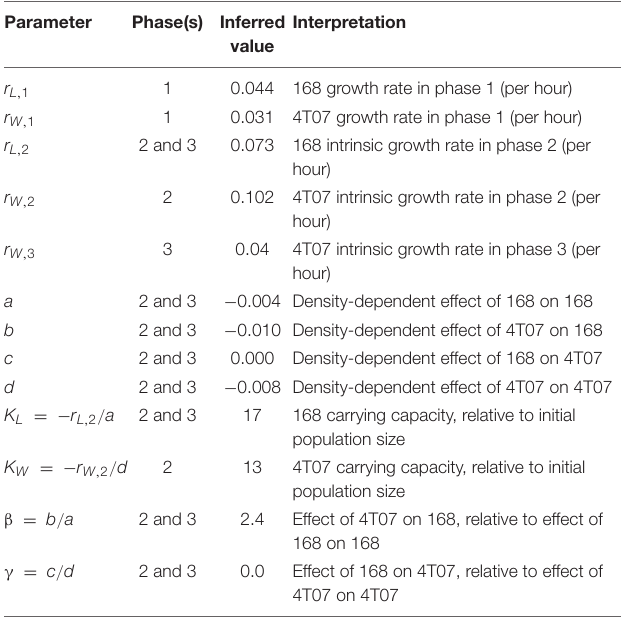
TABLE 1 | Mathematical model parameter values inferred from data.